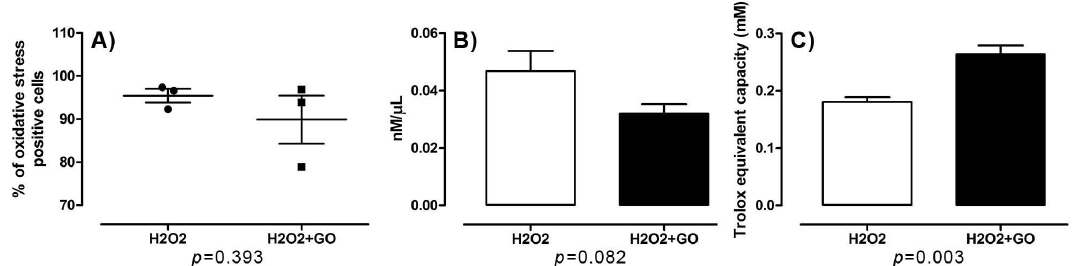
Figure 4. Effect of GO on ( A ) oxidative stress, ( B ) lipid peroxidation, and ( C ) total antioxidant capacity in equine satellite cell cultures exposed to hydrogen peroxide. ( A ) Each value is the mean ± standard error of the results from three different plates ( n = 3). Statistical analysis was performed using the unpaired t -test (two tailed) ( p < 0.05); ( B ) Each value is the mean ± standard error ( n = 6). Statistical analysis was performed using the unpaired t -test (two tailed) ( p < 0.05); ( C ) Data are expressed as means ± standard ( n = 6). Statistical analysis was performed using the unpaired t -test (two tailed) ( p <